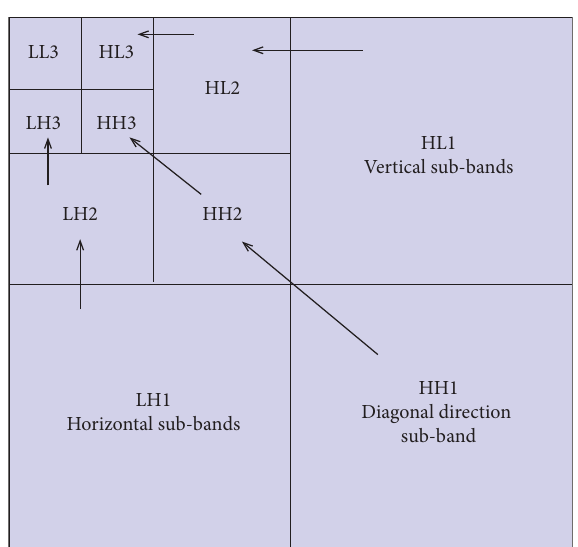
Figure 4: Wavelet decomposition high frequency subband di- rectional